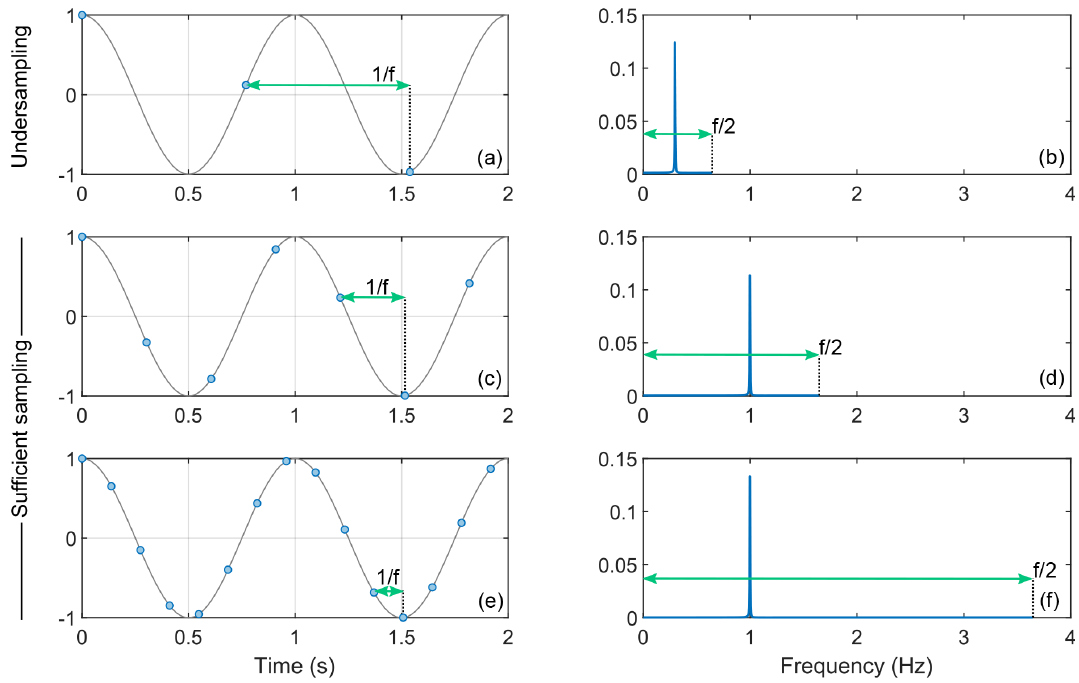
Figure 3. Illustration of signal sampling and the effect of undersampling. Panels (a) , (c) , and (e) represent a cosine oscillating at 1Hz in gray sampled with various frequencies f (1.3, 3.7, and 7.3Hz, respectively). The blue dots represent the samples. In each case, the Fourier transform is shown in panels (b) , (d) , and (f) , respectively. When the sampling frequency is lower than 1Hz, the peak cannot appear at 1Hz and is therefore found at a fictitious position. Table 1. List of parameters that were used to simulate the time domain signals and spectra in Fig. 4. Parameter Meaning Value used in K Number of points of the time domain signal 4096 L Number of points of the time domain signal including zero-filling/number of points of the Fourier transform t aq Acquisition time 5s f Sampling frequency or spectral width 819.200Hz τ D Dwell time (time between acquisition points) 1.2207ms T 2 Coherence’s relaxation time constant 1s Line broadening